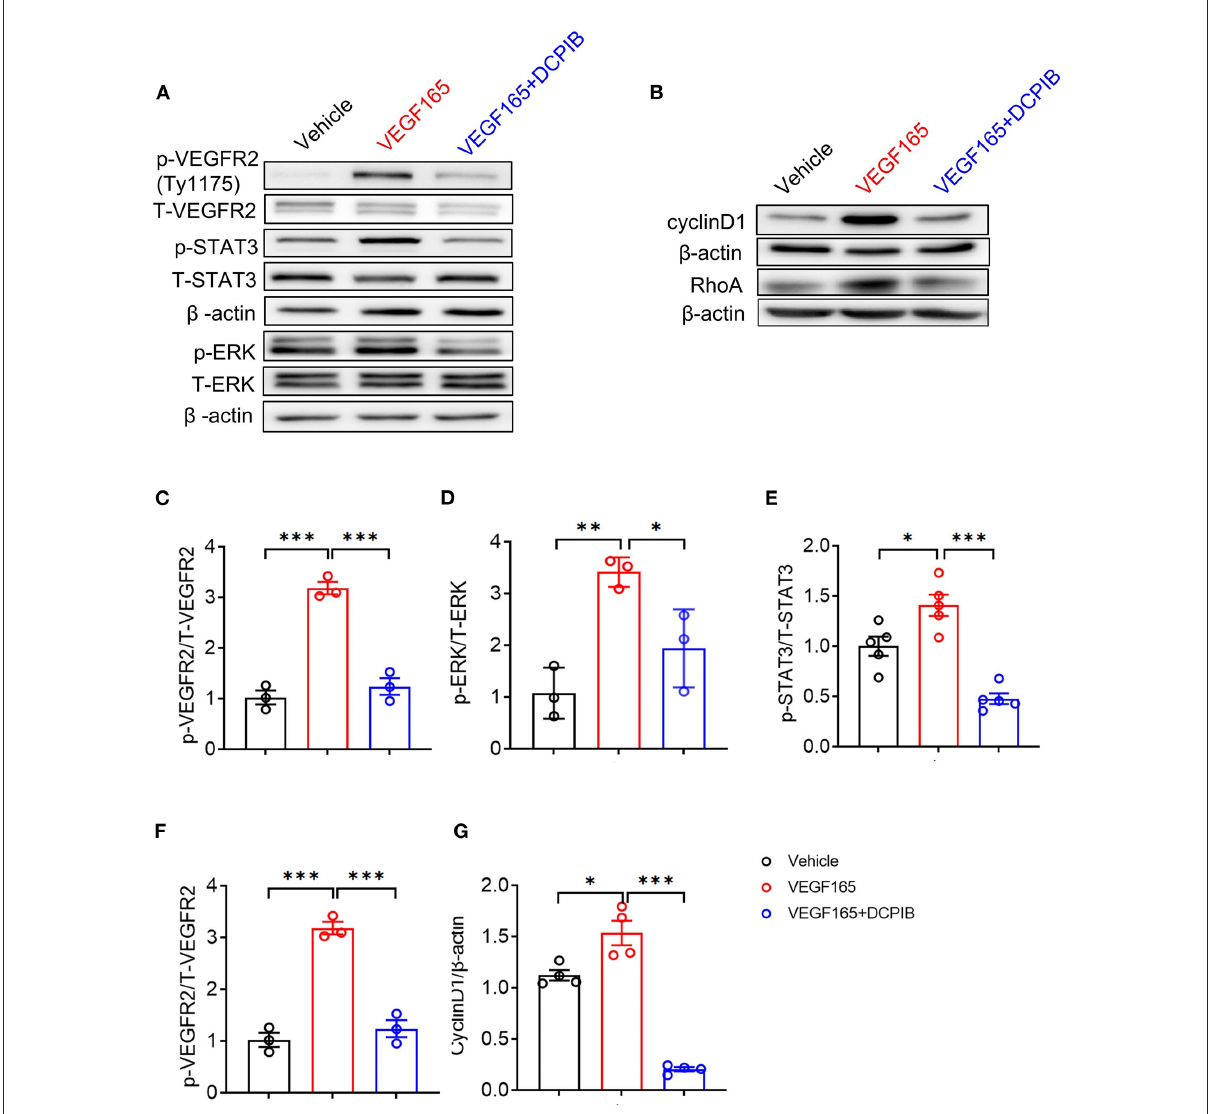
FIGURE6 DCPIB inhibited VEGFR2 phosphorylation and its downstream signaling pathways. (A) Western blot analysis of p-VEGFR2 (Tyr1175), p-STAT3 and p-ERK levels in HUVECs treated with vehicle, VEGF165 and DCPIB for 10min. Total VEGFR2, STAT3, ERK and β -actin were used as the loading control ( n = 3 ∼ 5). (B) Western blot analysis of RhoA and Cyclin D1 protein expression in HUVECs treated with vehicle, VEGF165 and DCPIB for 48h. β -actin was used as the loading control ( n = 4 ∼ 5). (C–G) Quantitative analysis of p-VEGFR2, p-STAT3, p-ERK, RhoA and Cyclin D1